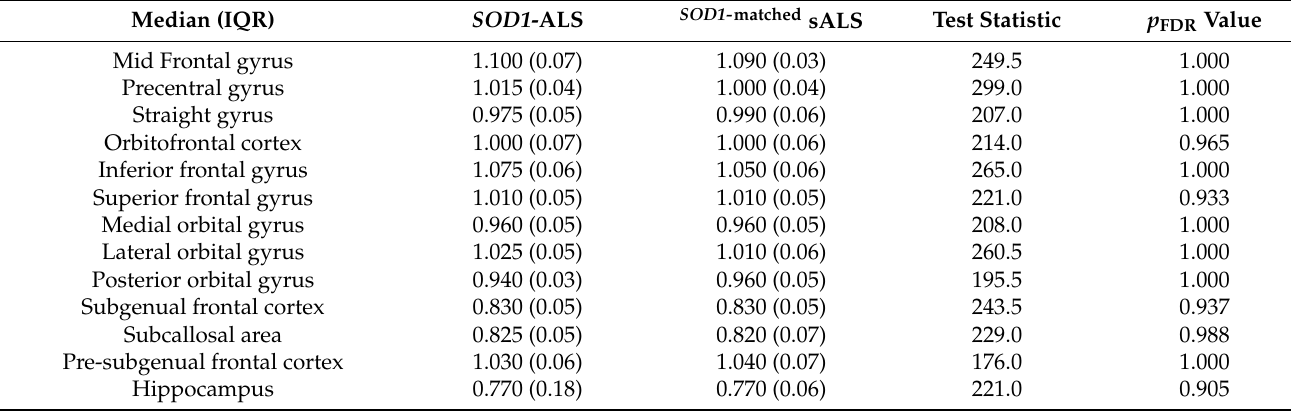
Table 4. Volume-of-interest (VOI)-based Mann–Whitney U test of 18 F-FDG SUVR between SOD1